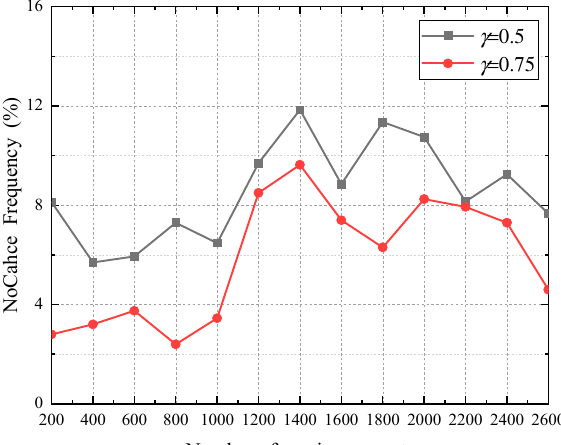
Figure 12. The service failure rate of TPPCD.